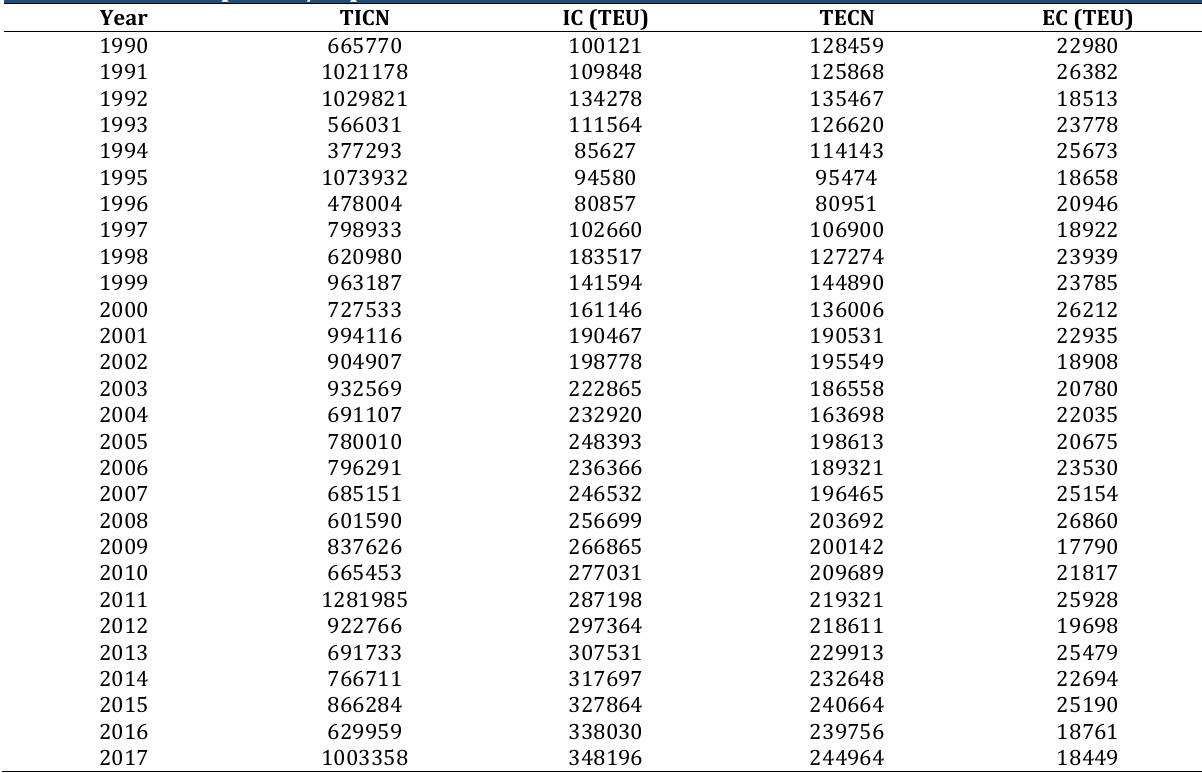
Table 8: Total imported/exported traffic and container